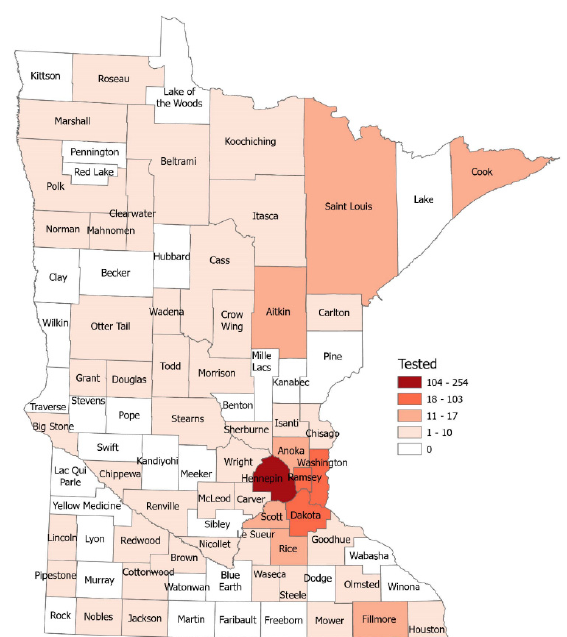
Figure 1. Map of tested study participants by county.